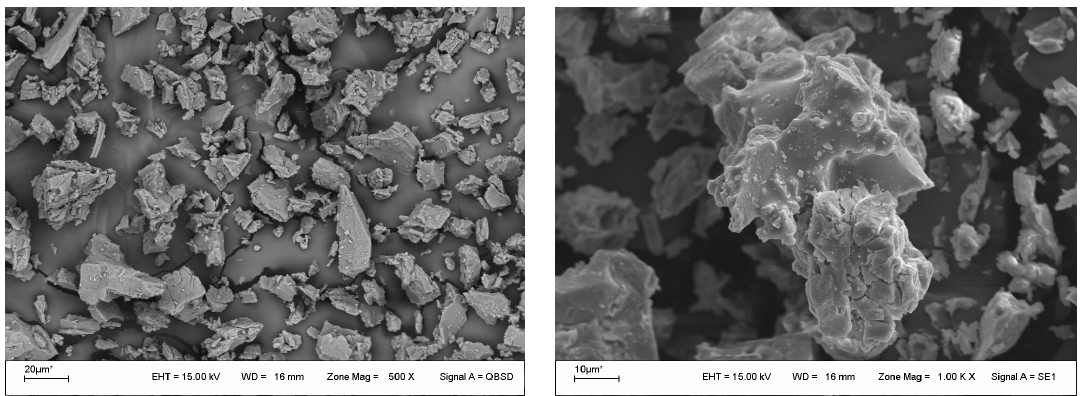
Figure 3. SEM micrograph of the mineral with thermal treatment ( β -spodumene).